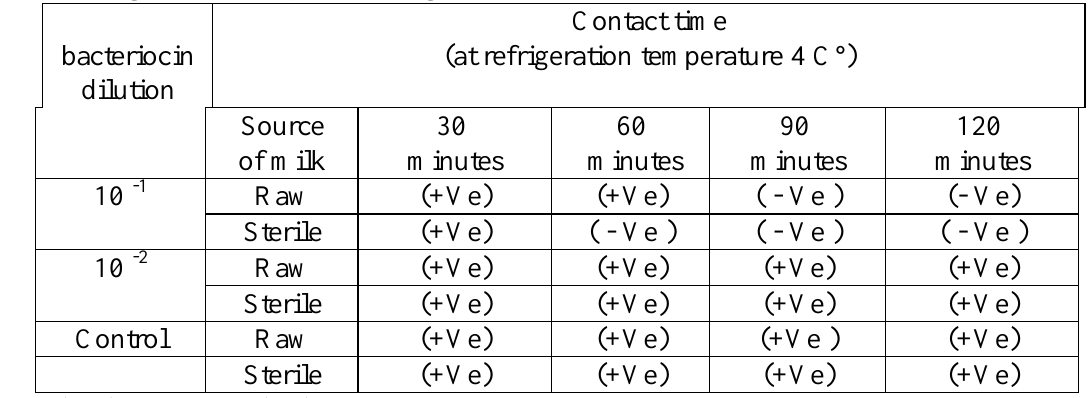
Table - 4- Effectiveness of diluted crude bacteriocins in raw and sterile milk samples stored at refrigeration temperature against stressed E.coli